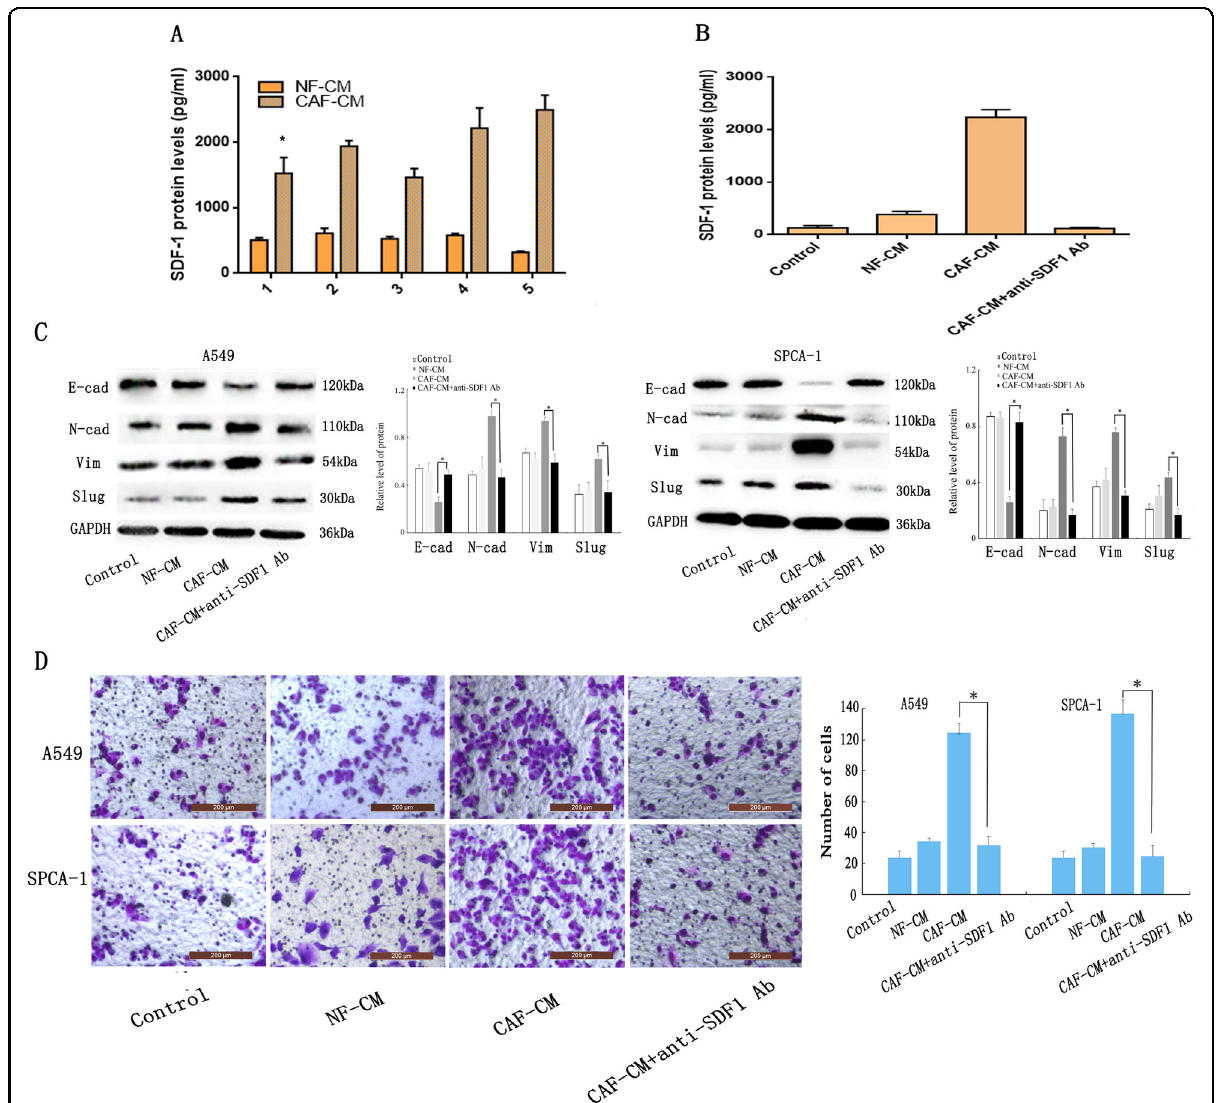
Fig. 3 SDF-1 triggers CAF-induced EMT and invasion in lung cancer cells. a , b SDF-1 protein levels in the conditioned medium quanti fi ed by ELISA. a Five groups of CAF and corresponding NF cultured separately for 72 h. b Lung cancers cells incubated with DMEM, NF-CM, CAF-CM, and CAF-CM + SDF-1 neutralising antibody for 24 h. c Western blotting analysis of epithelial and mesenchymal marker expression. d Transwell assay examining the invasiveness of cells; scale bar: 200 μ m.The error bars represent suggested the standard errors of the mean of the three individual experiments. * p <